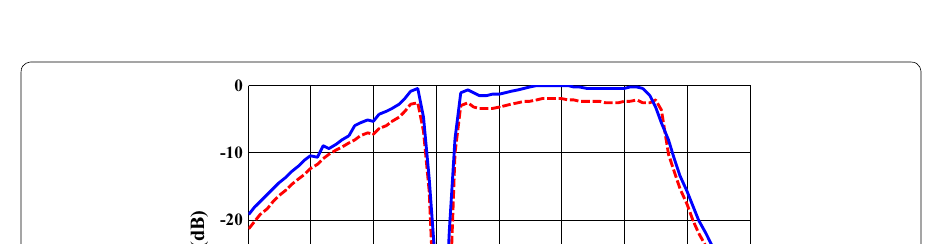
Fig. 9 Prototype of DB-BPF